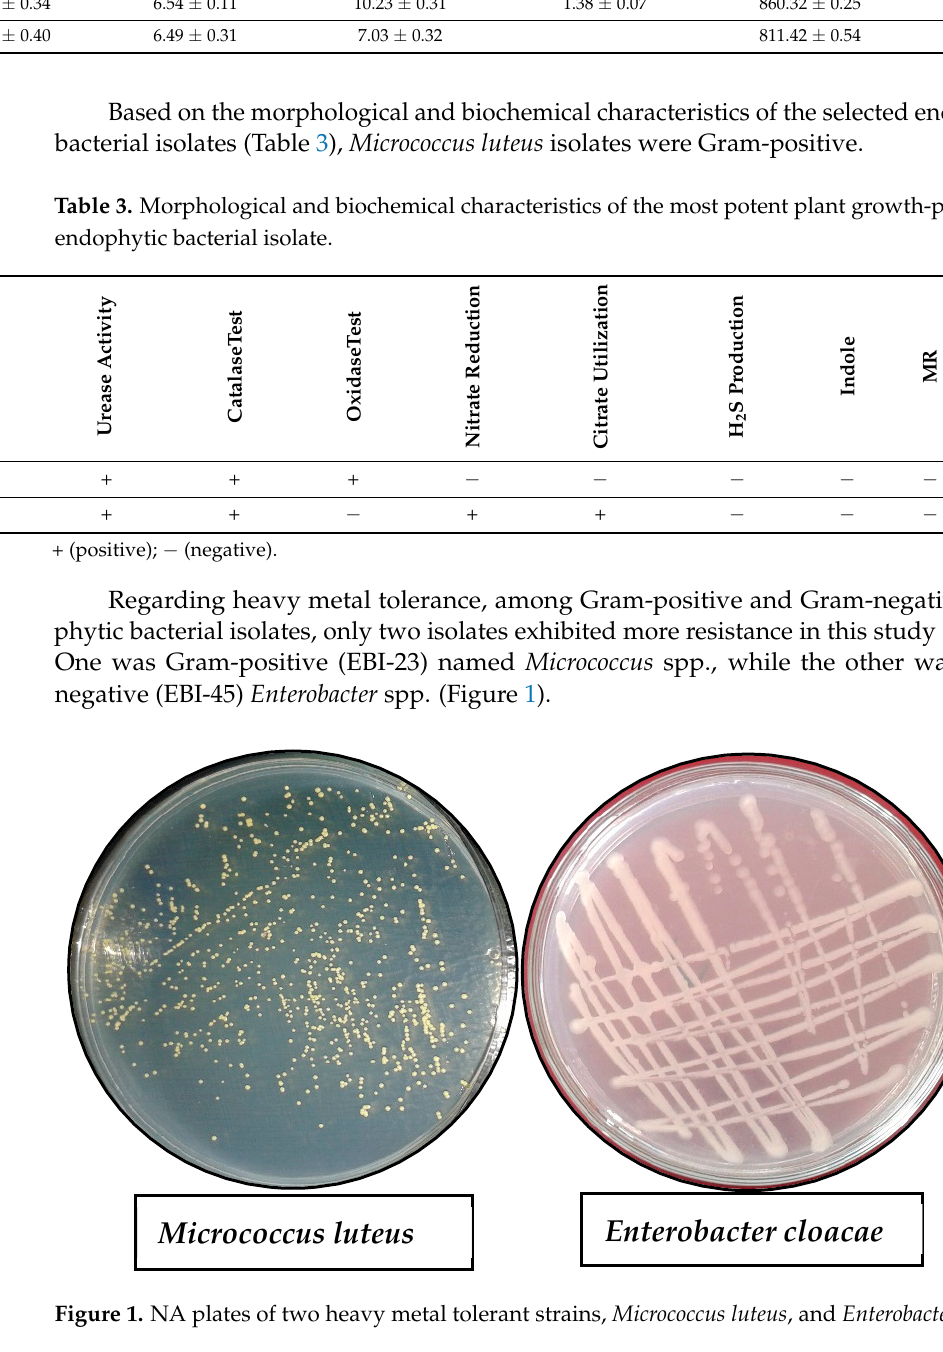
Table 4. Heavy metal resistance behavior of the most potent plant growth promoting endophytic bacterial isolate; +++ (normal growth); ++ (moderate growth); + (weak growth); − (no growth).